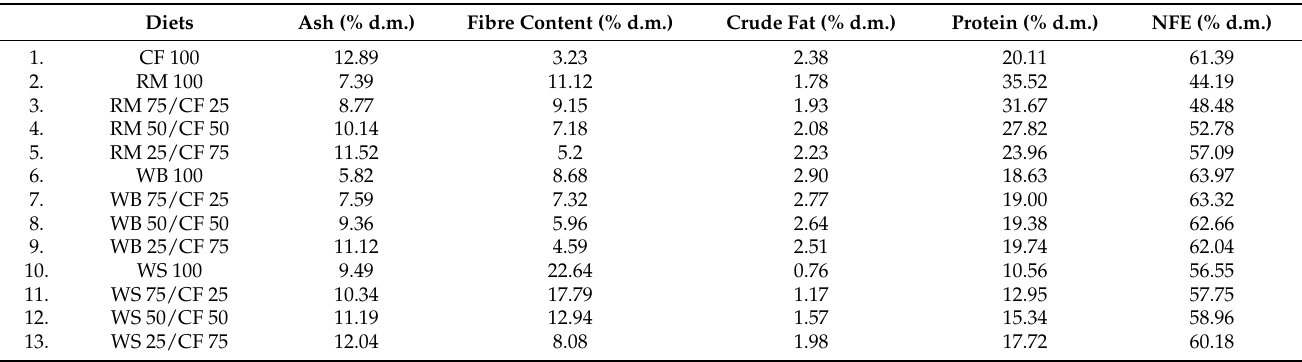
Table 1. Proximate composition of experimental